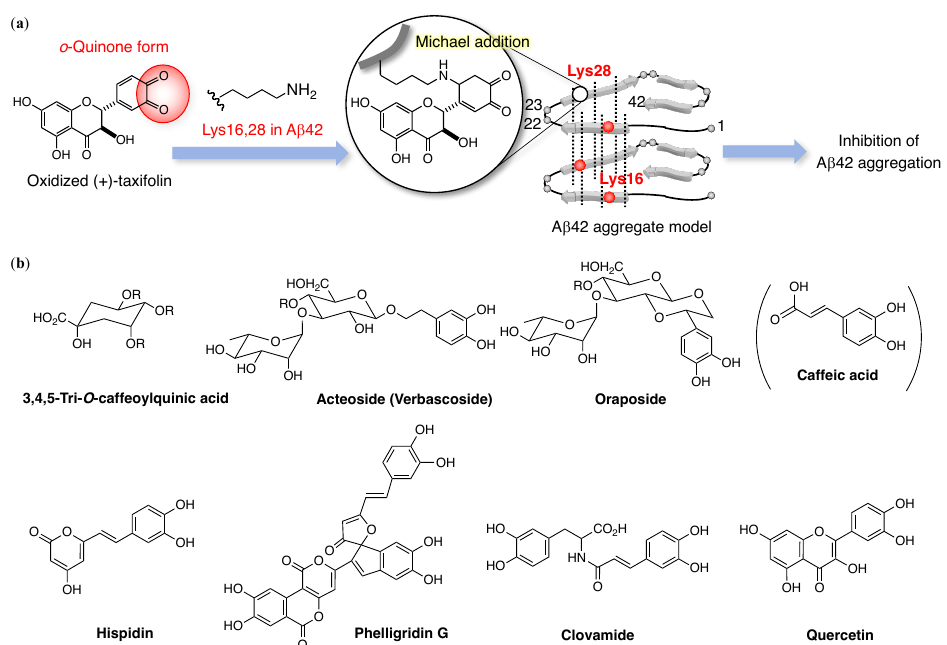
Figure 2. ( a ) Michael adduct of catechol-type flavonoids with Lys16 and 28 in A β 42. ( b ) Catechol-type compounds from natural products by Shigemori and coworkers, which have anti-A β 42 aggregation properties. R = ca ff